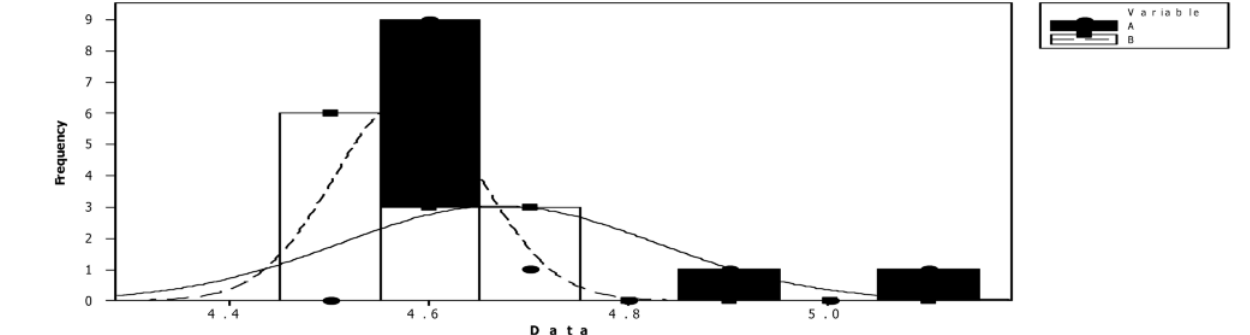
Figure 1: Results for pH in open field (A) and indoor